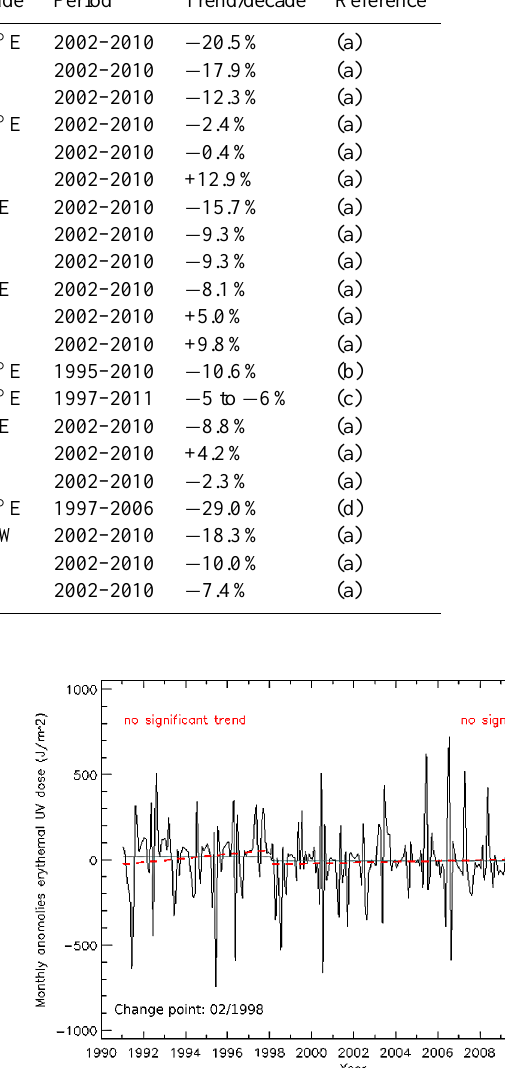
Table 8. Absolute and relative trends of aerosol optical depth at different stations from (a) Alpert et al. (2012), (b) Nyeki et al. (2012), (c) Fitzka et al. (2012) and (d) Kazadzis et al. (2007). MODIS-Terra, MODIS-Aqua and MISR measurements are represented by respectively “a”, “b” and “c” after the station name. Latitude/longitude Period Trend/decade